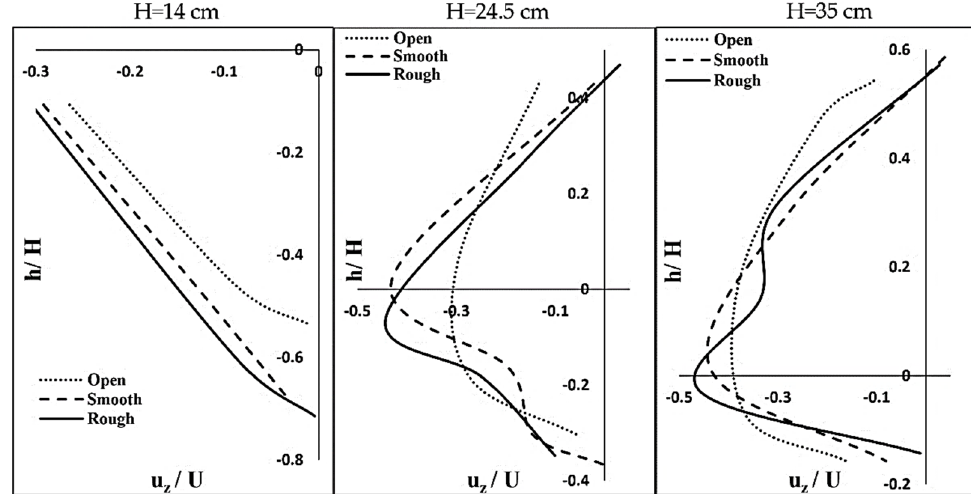
Figure 12. Vertical velocity profile (u z ) inside and outside the scour holes under the open channel, smooth covered, and rough covered flow conditions for the spur dike with an orientation angle of 90° for different water depths. ADV measurements subject to +/- 0.25 cm/s error.